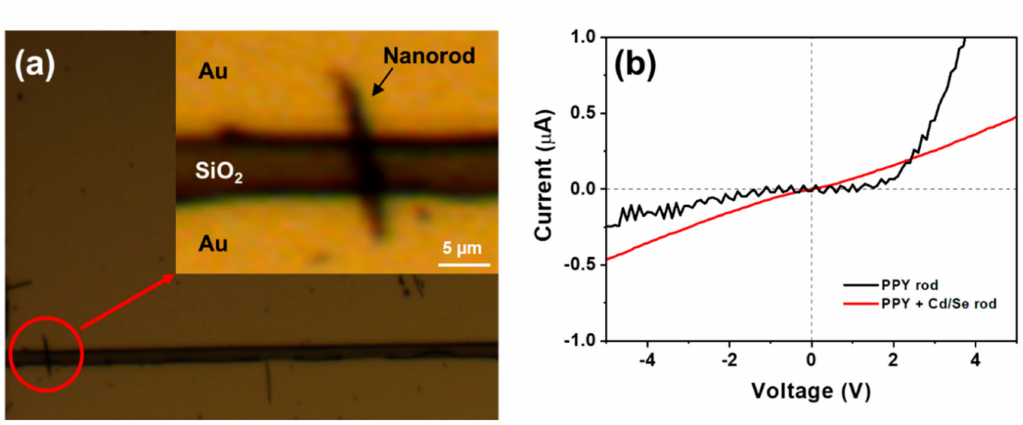
Figure 5. ( a ) Representative optical micrograph of a nanorod-bridged gapped Au electrode. ( b ) I-V characteristics of a CdSe-embedded PPy nanorod (black) and a control PPy nanorod without CdSe nanoparticles